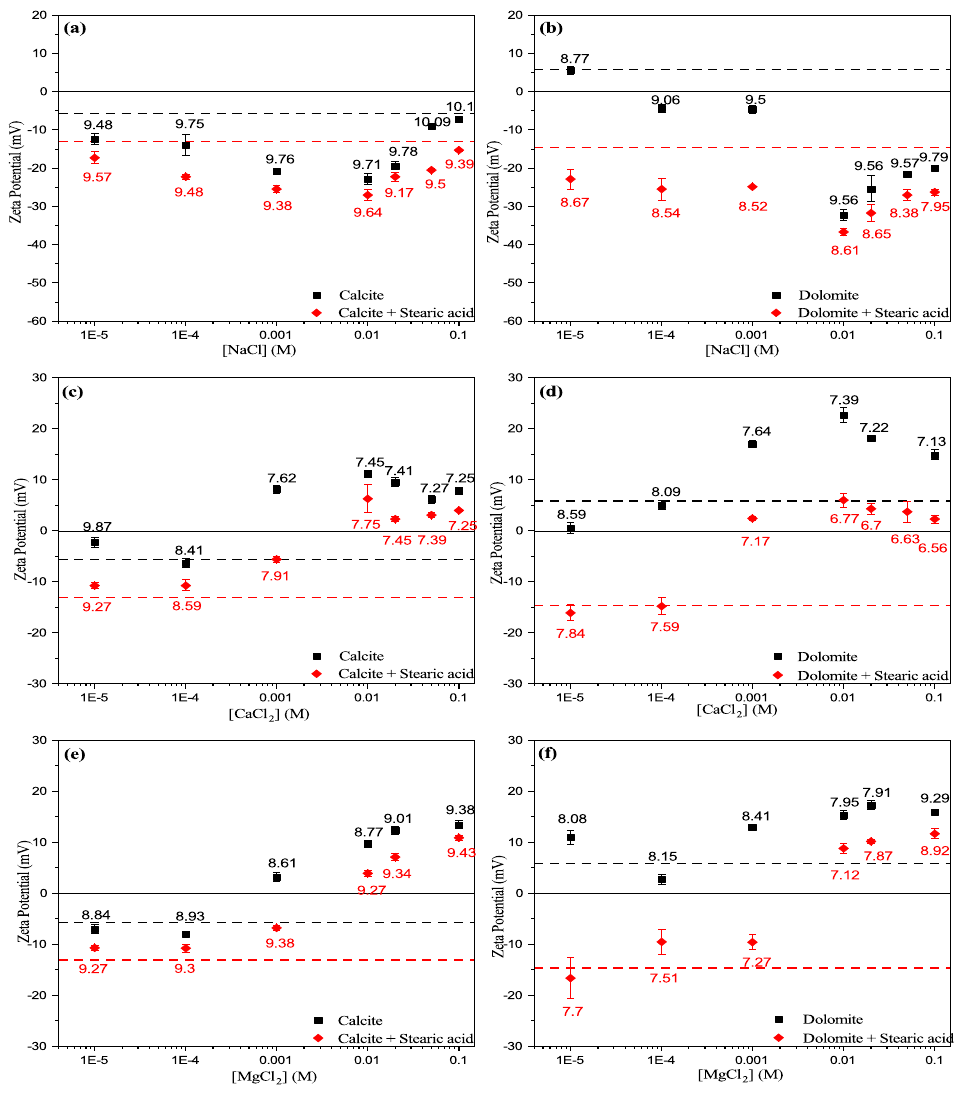
Figure 3. Comparison between the experimentally measured zeta potentials of unconditioned calcite and dolomite particles with the stearic acid-conditioned particles as a function of sodium chloride ( a , b ), calcium chloride ( c , d ), and magnesium chloride ( e , f ) aqueous electrolyte concentration. Measured pH values are reported above/below each point. Black dashed lines show zeta potential of the unconditioned carbonate particles in water and red dashed lines show zeta potential of stearic acid carbobate particles in